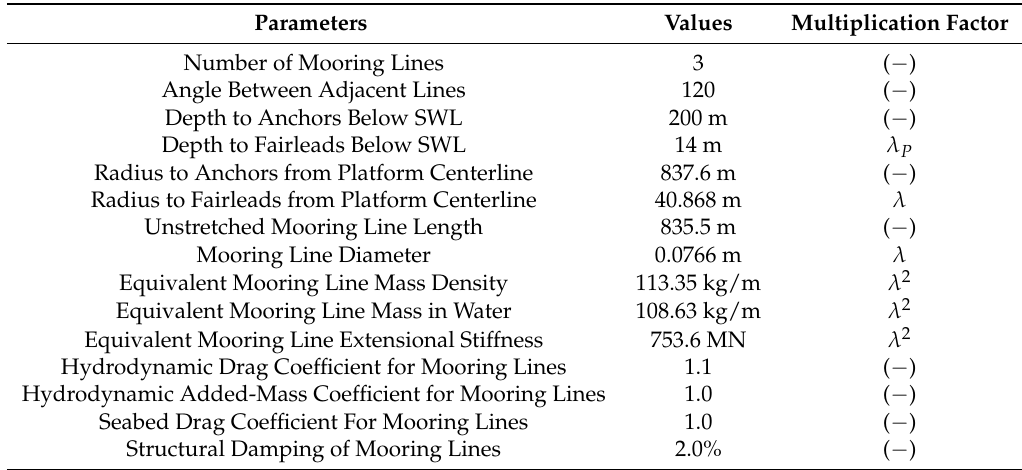
Table 4. Mooring system